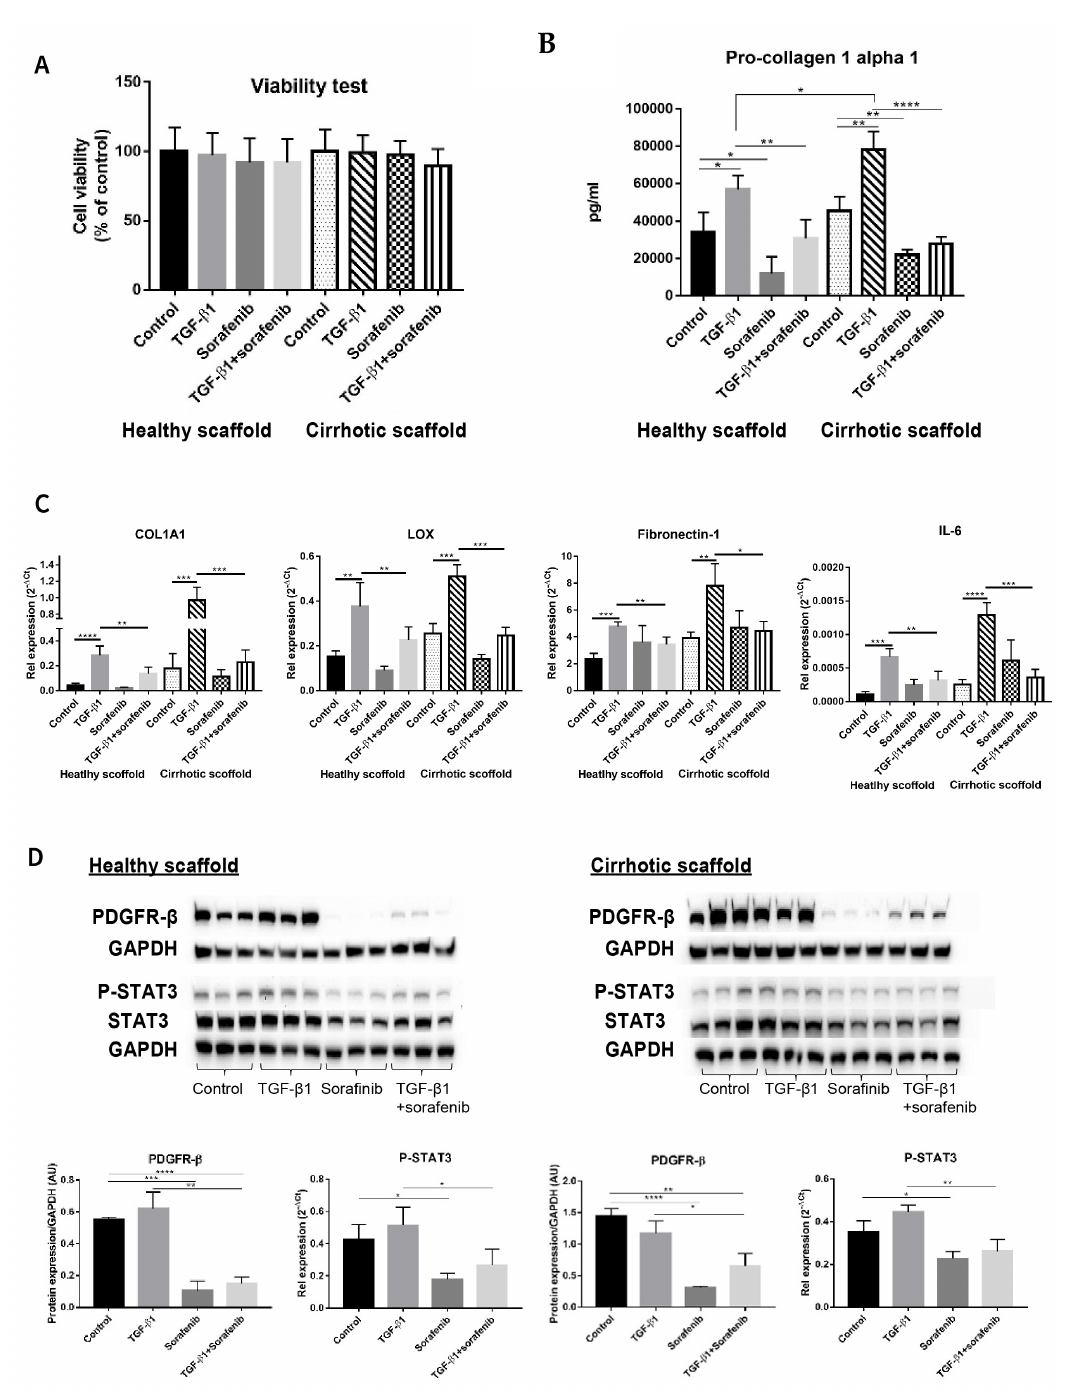
Figure 4. Validation of Sorafenib’s anti-fibrotic effect on LX2 -HepG2 co-culture model in 3D healthy and cirrhotic human liver scaffolds. ( A ) Viability response of LX2-HepG2 cells co-cultured in 3D ECM liver scaffolds to TGF- β 1 5 ng/mL, Sorafenib 7 µ M and combination therapy for 48 h. ( B ) Pro-collagen1 α 1 secretion in LX2-HepG2 cells co-cultured in 3D ECM scaffolds exposed to TGF- β 1 (5 ng/mL), Sorafenib (7 µ M), and combination therapy for 48 h. ( C ) Western blot and densitometry analysis of PDGFR- β , phosphorylated STAT3, and STAT3 expression from LX2/HepG2 cells co-cultured and treated with TGF- β 1 (5 ng/mL), Sorafenib (7 µM), and combination therapy for 48 h in 3D ECM scaffolds using GAPDH as a loading control. ( D ) Gene expression of pro-fibrogenic markers of LX2/HepG2 cells co-cultured and treated with TGF- β 1 (5 ng/mL), Sorafenib (7 µM), and combination therapy for 48 h in 3D ECM scaffolds. ( n = 4 scaffolds per condition, * p ≤ 0.05, ** p ≤ 0.01, *** p ≤ 0.001, and **** p ≤ 0.0001). (Figure S1: Whole blot showing all the bands with all molecular weight markers on the Western)